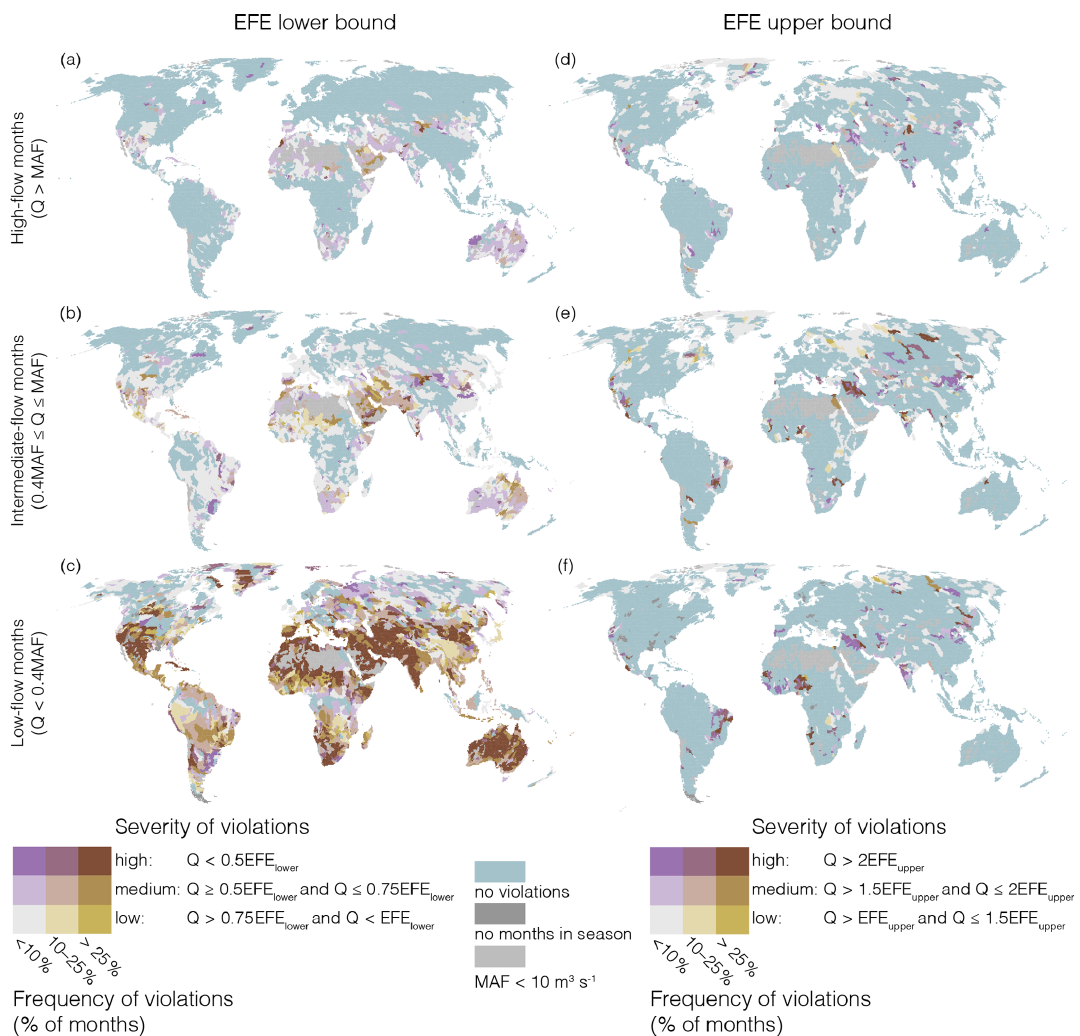
Figure 3. Seasonal frequency and severity of environmental flow envelope (EFE) violations of the lower bound (a–c) and the upper bound (d–f) . Q stands for monthly discharge, MAF for mean annual flow, EFE lower for the EFE lower bound, and EFE upper for the EFE upper bound. For each sub-basin in each season, violation frequency corresponds to the fraction of violated months out of all months in that season, and violation frequency to the mean violation ratio during those violated months. If there are no months between 1976 and 2005 during which discharge would fall below the low-flow season limit, the respective sub-basin is classified as “no months in